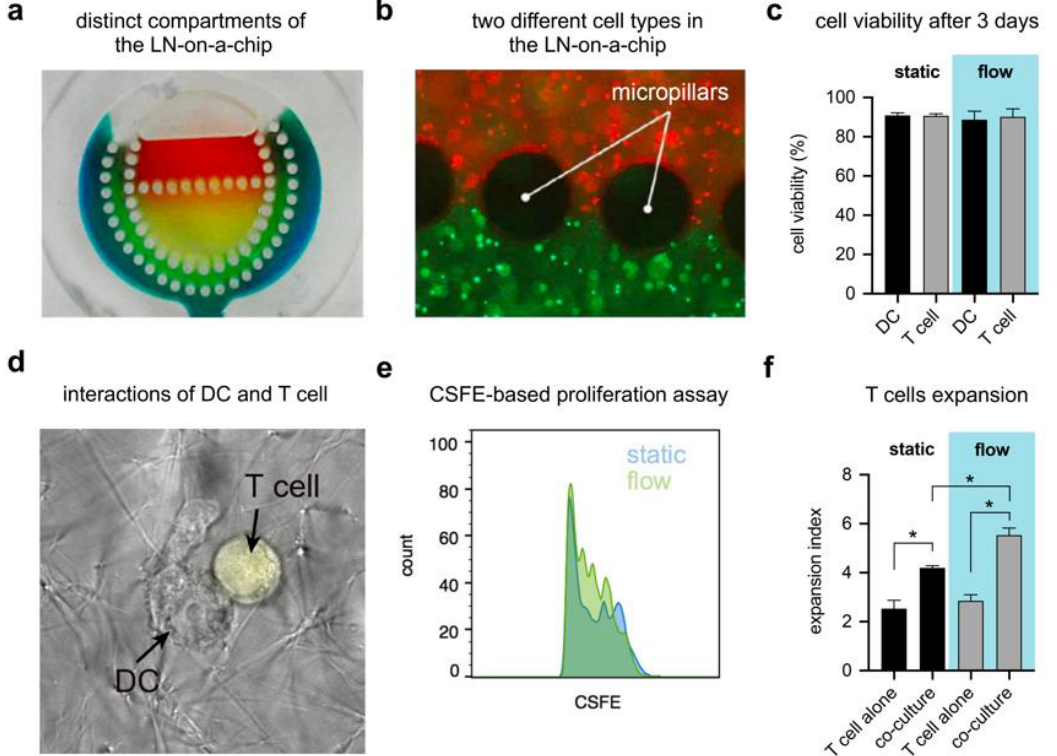
Figure 4. Biomimicry and cytocompatibility of the LN-on-a-chip. ( a ) Confinement of di ff erent hydrogels within distinct compartments of the LN-on-a-chip, which is facilitated by micropillars. ( b ) Proof-of-concept picture showing two di ff erent fluorescently labelled immune cells (Jurkat cells—red, THP-1—green), each in a distinct compartment within the LN-on-a-chip. ( c ) Cell viability of two di ff erent immune cell types, DC and Jurkat, cultured within the LN-on-a-chip for 72 h. The viability is over 90% for all the cell types. ( d ) Interaction between DC and Jurkat cells. Jurkat cells migrate across micropillar boundaries and seek DCs. ( e ) Carboxyfluorescein succinimidyl ester (CSFE) proliferation assay shows enhanced proliferation of cells with perfusion over 72 h. Proliferation of cells was higher in the LN-on-a-chip compared to conventional microwell plates. ( f ) T cells co-cultured with DCs show significantly enhanced proliferation, further augmented by media perfusion. Data are represented as mean ± SD; * significance level of p <